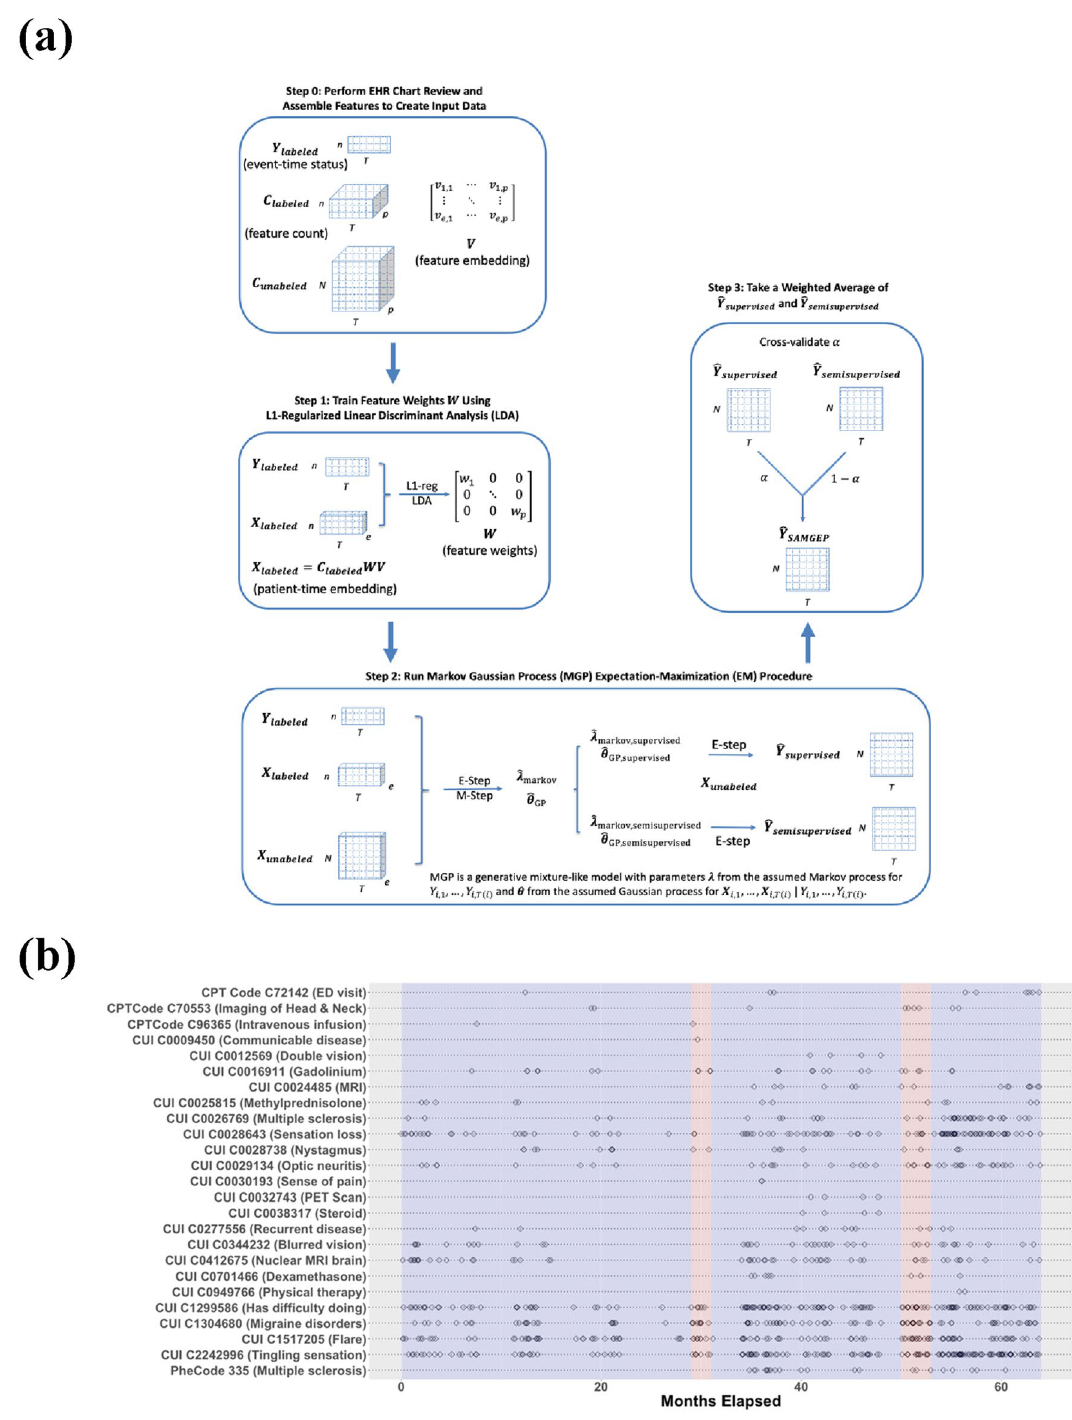
Figure 1. ( a ) Schematic of the overall SAMGEP algorithm. ( b ) Depiction of the sparsity and temporal irregularity of EHR data. In this study we aim to predict multiple sclerosis (MS) relapse event times (red bands) using timestamped EHR feature observations (black